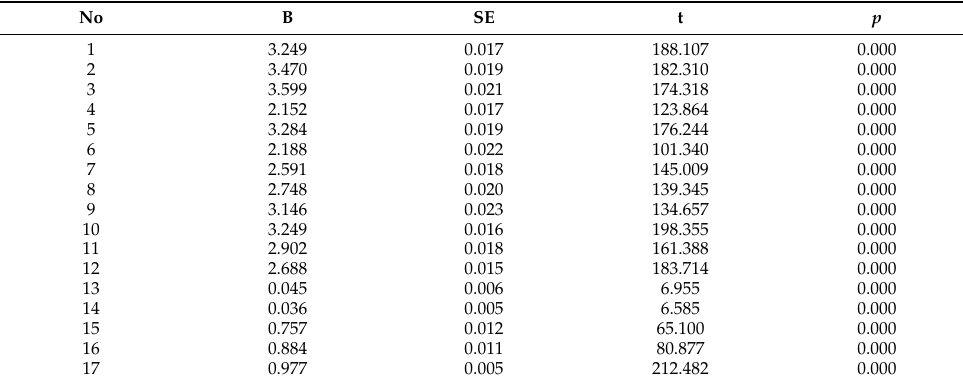
Table A1. Multivariate analysis of the variance indicator variable